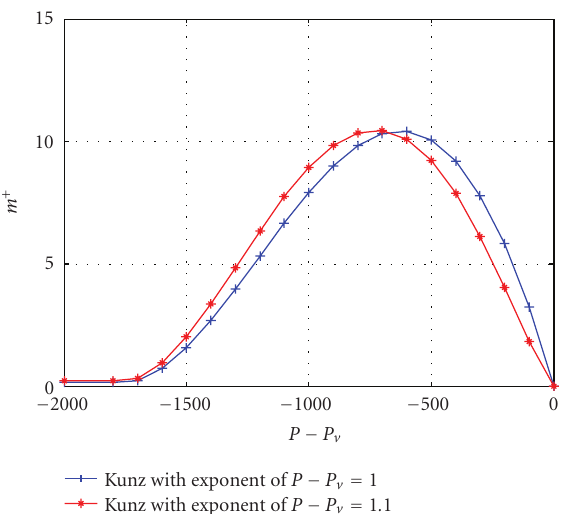
Figure 14: Vaporization term for two values of the exponent of P − P v .